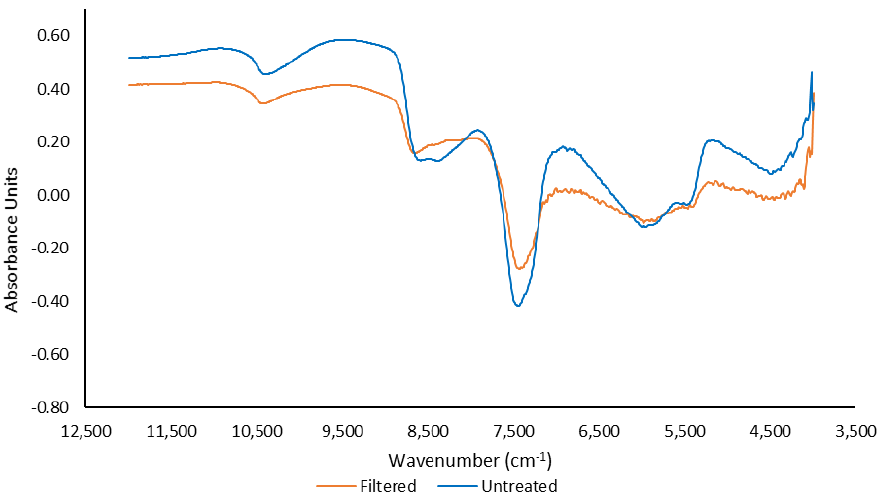
Figure 3. Average filtered and untreated spectra for DR-FT-NIR spectroscopy.